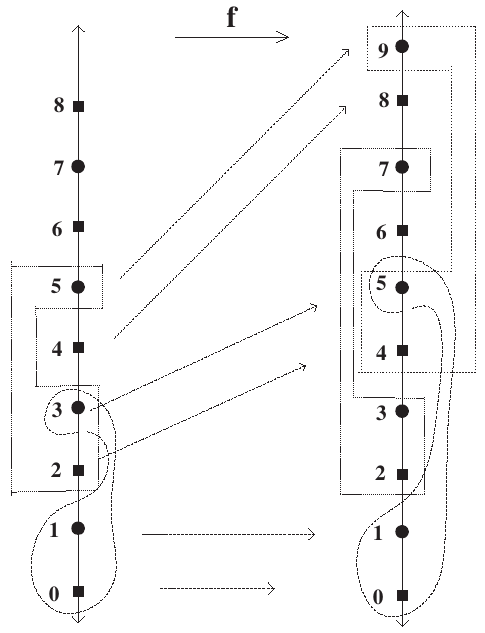
Figure 2. Non-homeomorphism between T 1 and T 2 . In particular, see the elements 2, 3, 6, and 7 in ( Z , T ) , and so 2